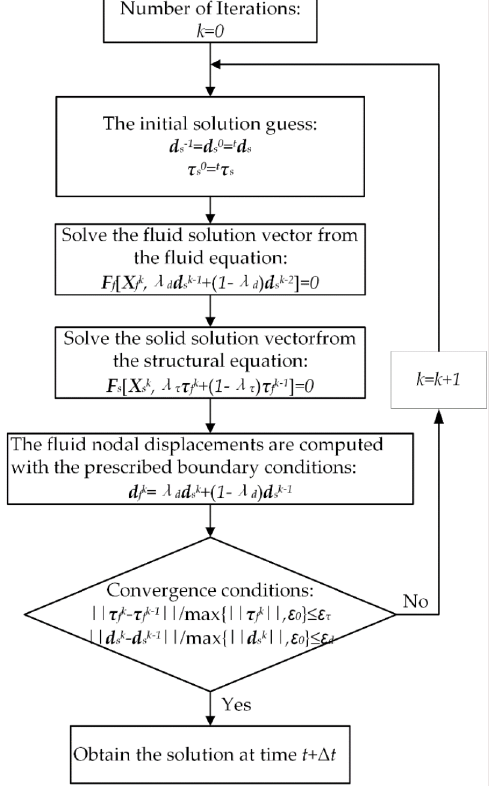
Figure 6. Decoupling method of the FSI model.